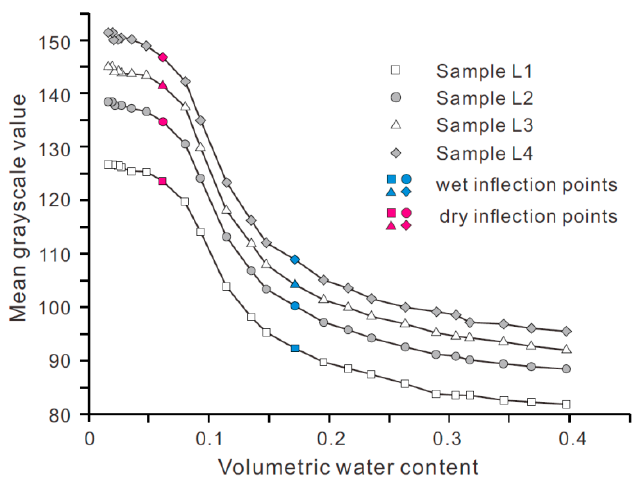
Figure 9. WGCCs for samples tested at different levels of illuminance.